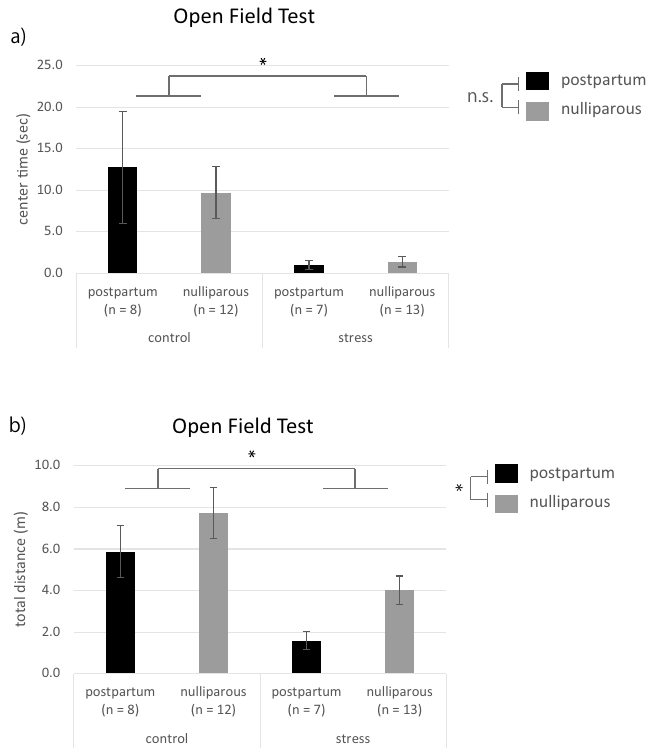
Figure 2. Comparison of the center time and total distance on the open field test. Data are shown as the mean ± standard error. ( a ) Center time, * p < 0.05 (two-way analysis of variance) for control versus stress. ( b ) Total distance, * p < 0.05 (two-way analysis of variance) for control versus stress and postpartum versus nulliparous. n.s. Not